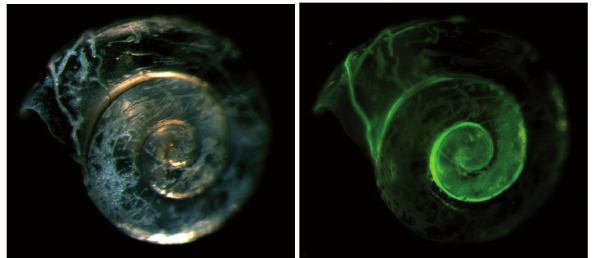
Fig. 10. Example for “repair” calcification: shell degradation of Limacina helicina (left, oblique transmitted light) and the respective regions of “repair” calcification indicated by enhanced fluorescence due to calcein incorporation